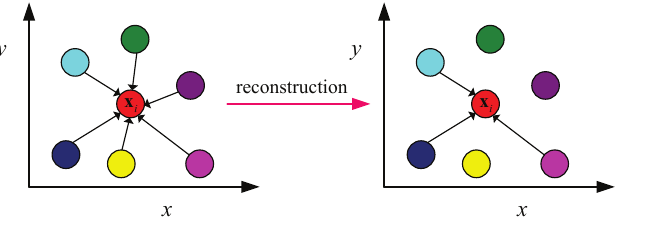
Figure 1. Instance x i is only reconstructed by a few important neighbors in an incomplete data set, rather than being reconstructed by all the